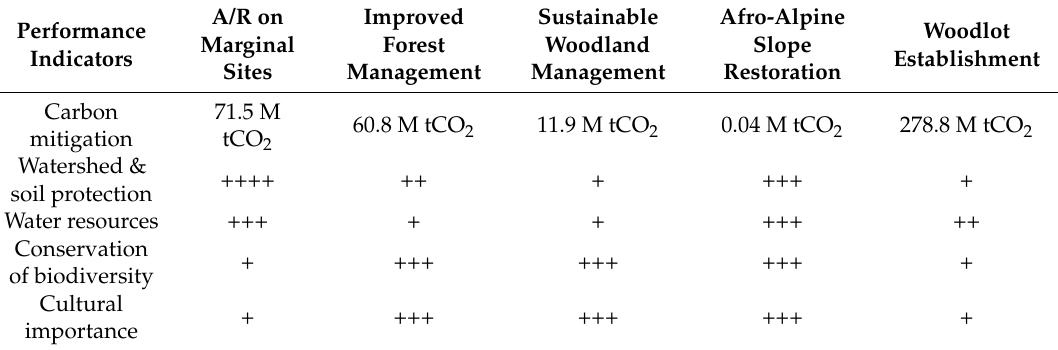
Table 4. Environmental performance indicators of identified FLR options for